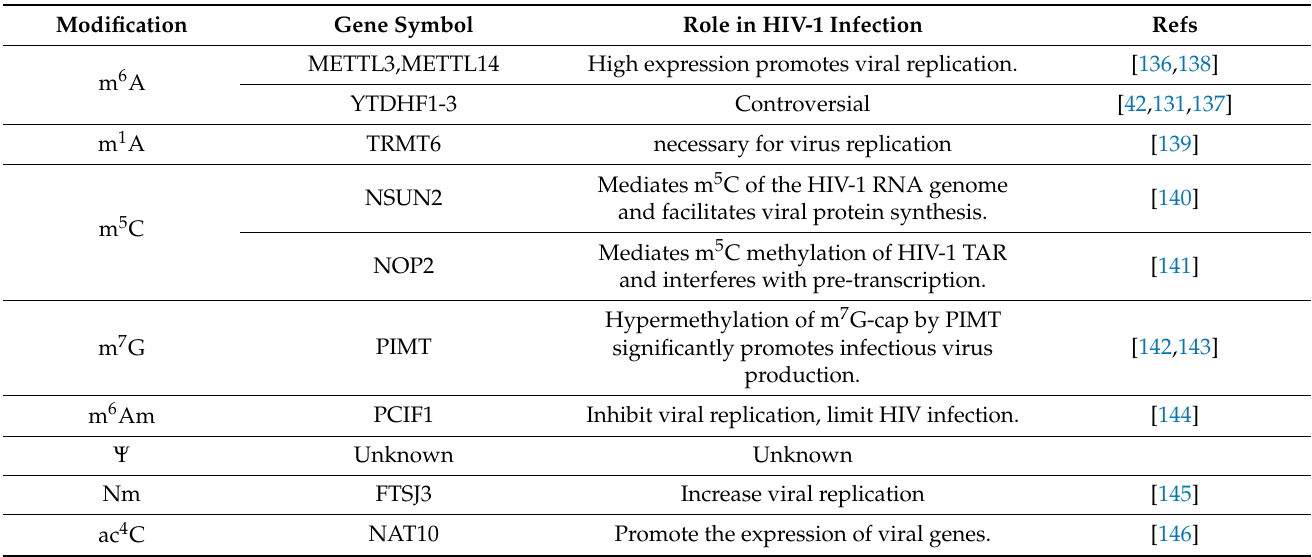
Table 2. Major roles of epitranscriptomic factors in HIV-1